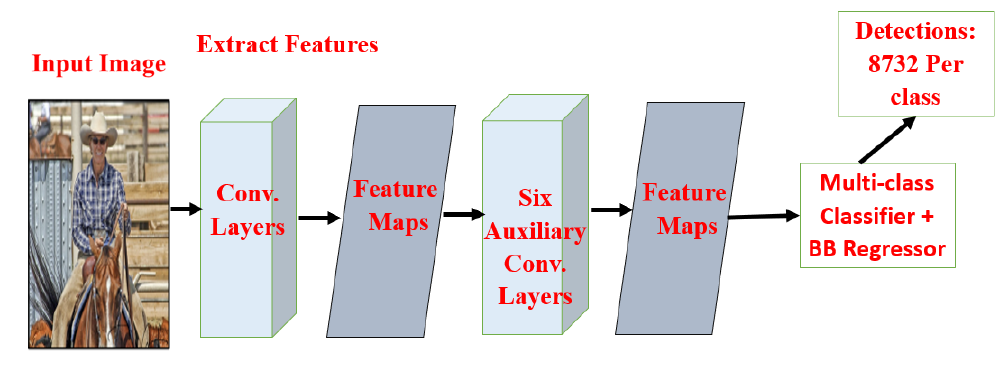
Figure 11. Single shot multi-box detector architecture